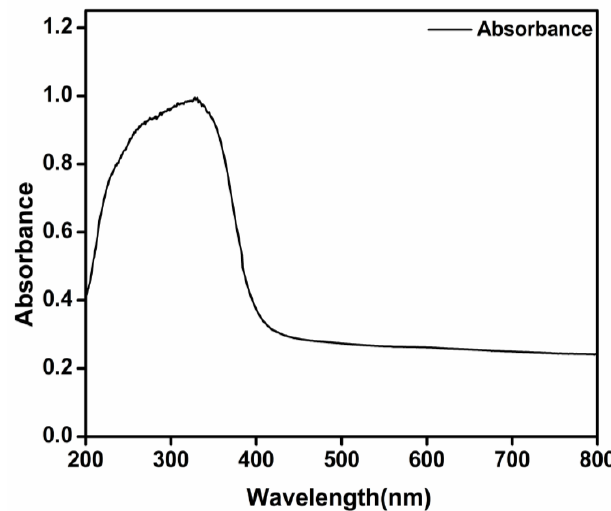
Figure 9. Ultraviolet (UV)-visible absorption spectrum of green-synthesized TiO 2 nanoparticles.